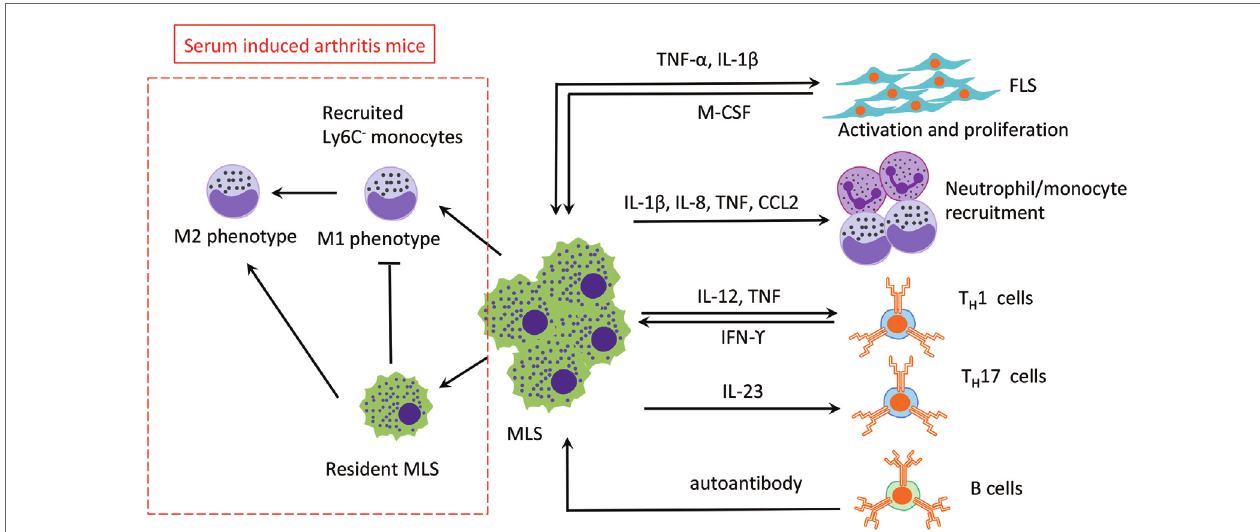
FiGuRe 3 | The roles of MLS in RA. The three main effects of MLS in RA are mediated by cytokines secretion: (1) FLS activation, (2) recruitment of neutrophil/ monoctes, and (3) T cells polarization. MLS are also affected by direct cell contact or indirect cytokine production by FLS, T cells, and B cells (autoantibody). In addition, in a serum-induced arthritis mouse, circulation recruited Ly6C − monocytes limits development of arthritis mice and promotes the switch from M1 to M2 in the arthritis joint. Abbreviations: TNF, tumor necrosis factor; IL-1 β , interleukin 1 β ; IL-8, interleukin 8; IL-23, interleukin 23; M-CSF, macrophage colony-stimulating factor; IFN- γ , interferon γ ; CCL2, monocyte chemoattractant protein 1; T H 1, type 1T helper cells; T H 17, type 17 helper cells; MSL, macrophage-like synoviocytes; FSL, fibroblast-like synoviocytes; RA, rheumatoid arthritis.